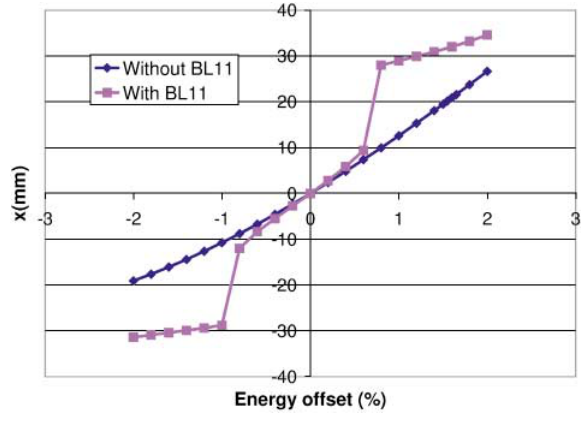
FIG. 7. (Color) BETA simulation 2h x at BL11.